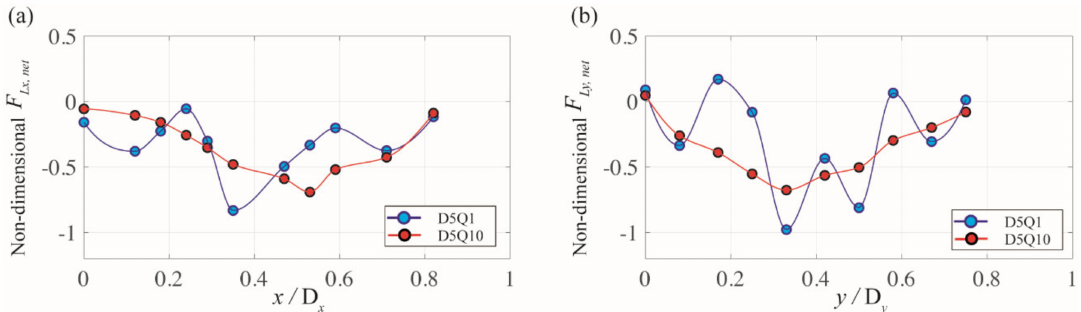
Figure 8. Variation in the ( a ) x -directional and ( b ) y -directional net force exerted on the 5- µ m particle along the line of symmetry of the rhombic microchannel. The blue and red symbols represent flow rates of 1 and 10 µ L / min,